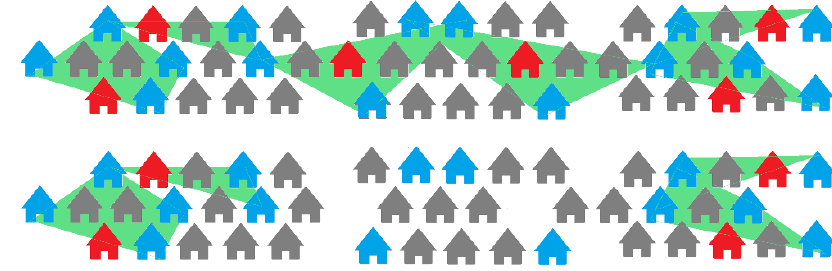
Figure 6. Coverage on a street after application of Filter